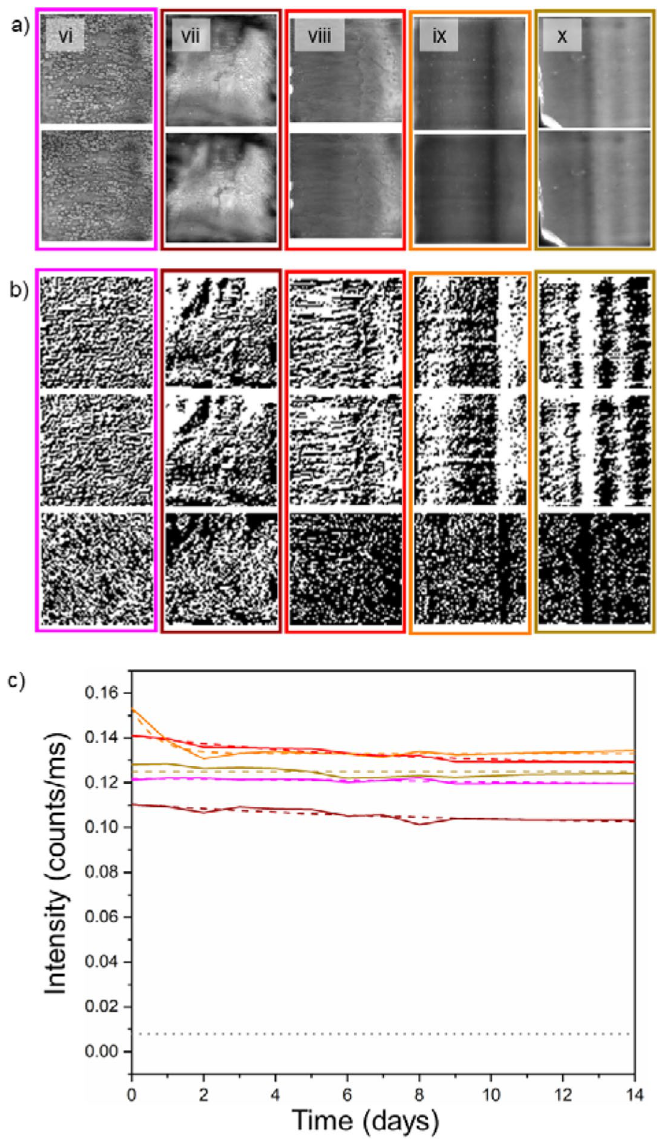
Figure 4. ( a ) Top—Images showing the photoluminescence (PL) intensity maps from each formulation of the Group 2 tokens captured on the day they were created (day 0). Bottom—PL images of each Group 1 token type captured on day 14. The intensity of the day 14 image has not been increased post capture, as it was in Fig. 2. For each token type the polymer used was: (vi) PMMAPLMA, (vii) PMSPLMA, (viii) PSPLMA, (ix) PVDFPLMA, (x) SEBSPLMA. ( b ) The top of each coloured rectangle is the R-LBP generated fingerprint of the labelled QD-PUF on day 0. The middle of each coloured rectangle is the fingerprint from day 14. In the bottom image of each rectangle, the white pixels indicate the pixels that changed in value in the fingerprint between day 1 and 14. The percentage of pixels that changed value and the composition of each is as follows: (vi) PMMAPLMA, 46.5%, (vii) PMSPLMA, 41.2%, (viii) PSPLMA, 19.5%, (ix) PVDFPLMA, 24.12%, (x) SEBSPLMA, 15.4%. ( c ) The average PL intensity from each token type as a function of time since their creation. An exponential decay fit was applied to each (dashed line). The grey dotted line represents the background noise signal from the CCD